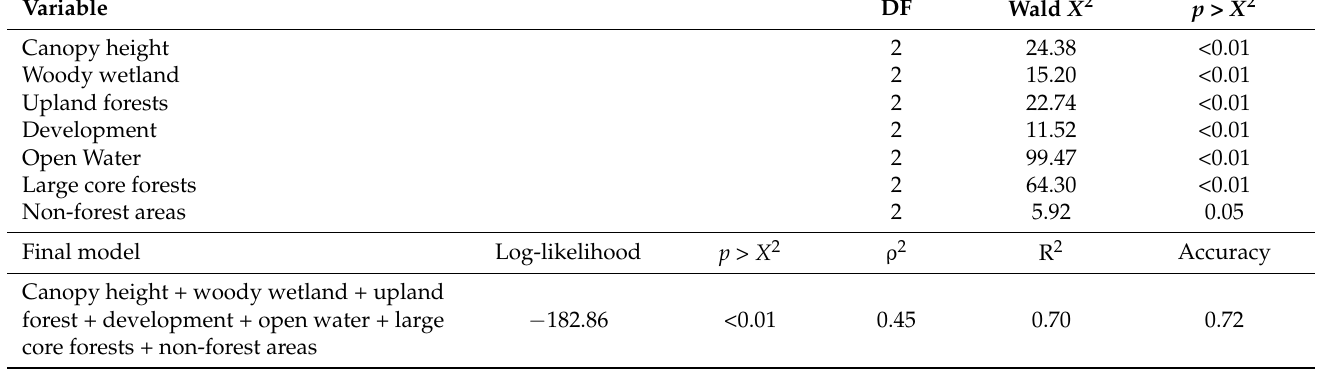
Table 1. Parameters included in a top multinomial logistic regression model as selected by AIC to assess second- and third-order habitat selection by northern long-eared bats ( Myotis septentrionalis ) at the North Carolina Wildlife Resource Commission’s North River Game Land (NRGL) in Camden and Currituck counties, North Carolina, 2019.